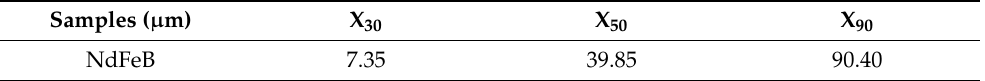
Table 3. Particle size analysis of NdFeB-powder after demagnetizing, grinding, and sieving.